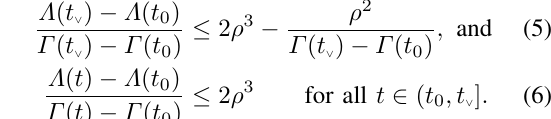
Fig. 2: The user requests Λ ( t ) − Λ ( t 0 ) (black line) are compared against 2 ρ 3 ( Γ ( t ) − Γ ( t 0 )) and 2 ρ 3 ( Γ ( t ) − Γ ( t 0 )) ± ρ 2 (gray lines) to find ρ ( t 0 ) . Solid gray lines correspond to density ρ = ρ 1 that satisfy (3)–(4) or (5)–(6), respectively, while dashed lines correspond to ρ = ρ 2 with no ρ ∨